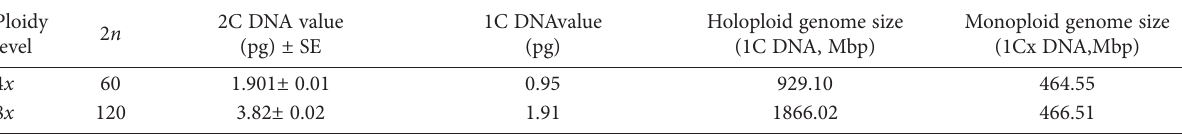
Table 2. Mean genome size (2C DNA) in the tested S. mutica (n = 5).